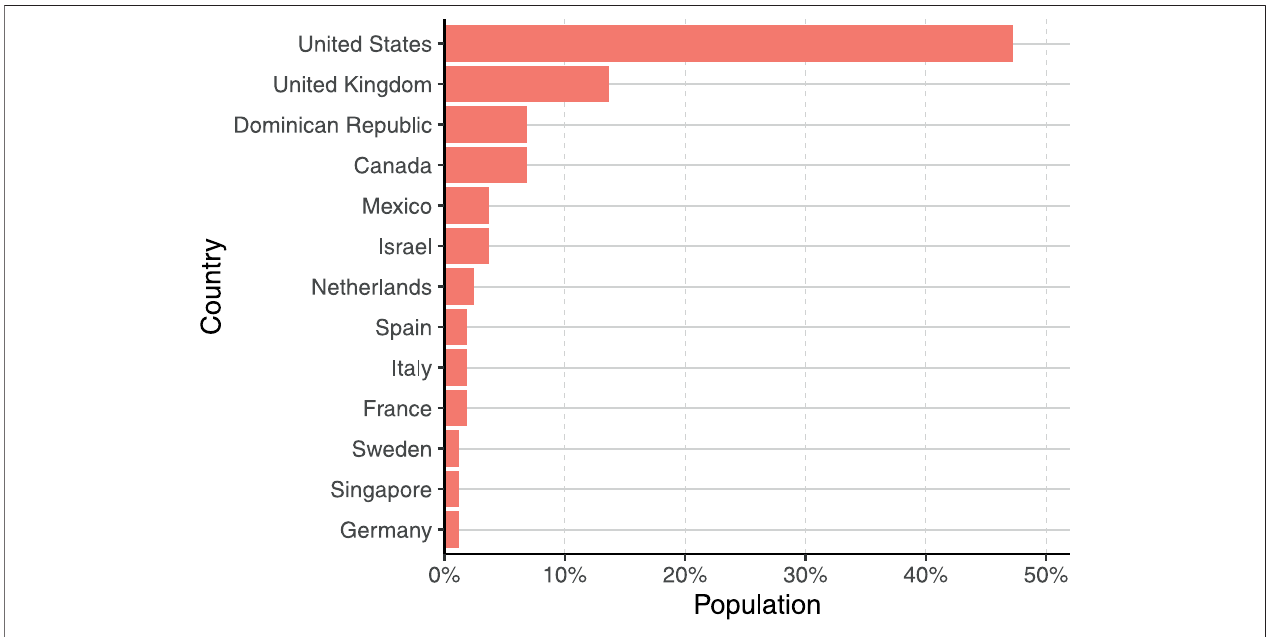
FIGURE 6 | List of countries participants were situated in while conducting the studies. The list omits countries with less than 1% representation.